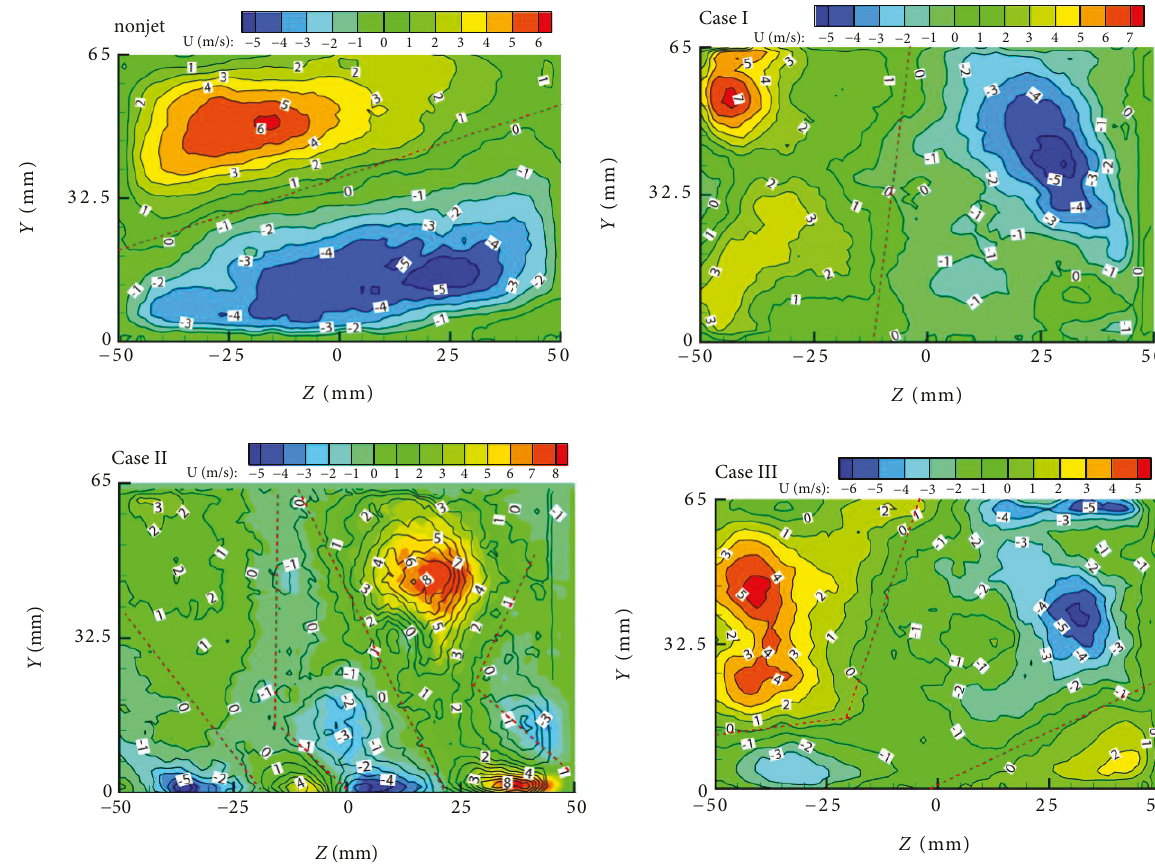
Figure 14: Axial velocity contour on the X = 48 mm